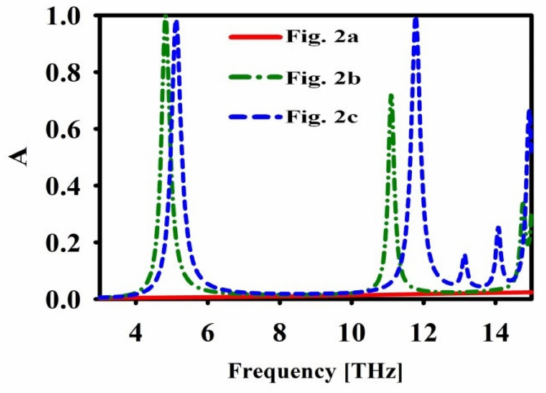
Figure 3. Absorption coefficient (A) of the different structures reported in Figure